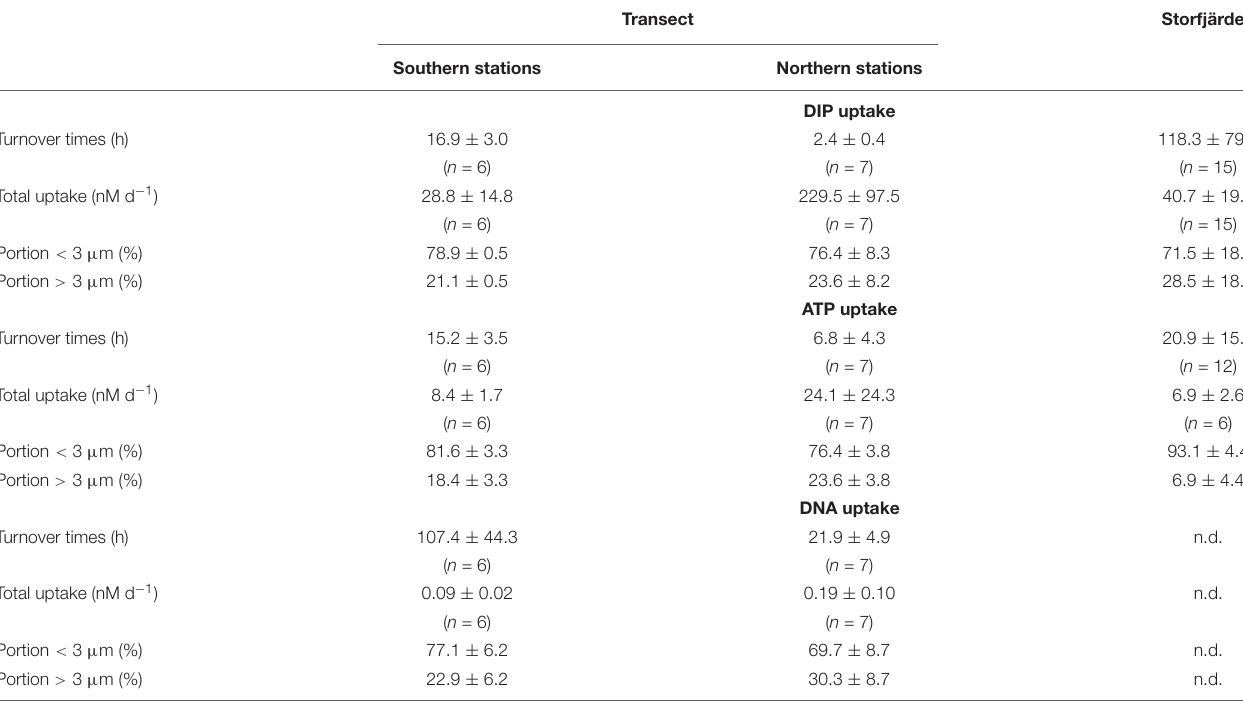
TABLE 6 | Mean values and standard deviation of turnover times, uptake rates of DIP, dATP-P, and dDNA-P and its distribution into size fractions. Transect Storfjärden